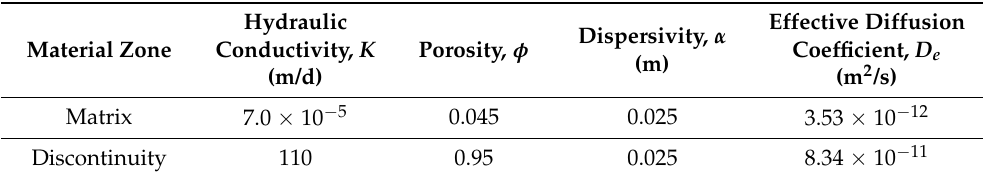
Table 2. Hydrodynamic and transport parameters of the matrix and the discontinuity (fracture) of the 2-D reactive transport model (adapted from